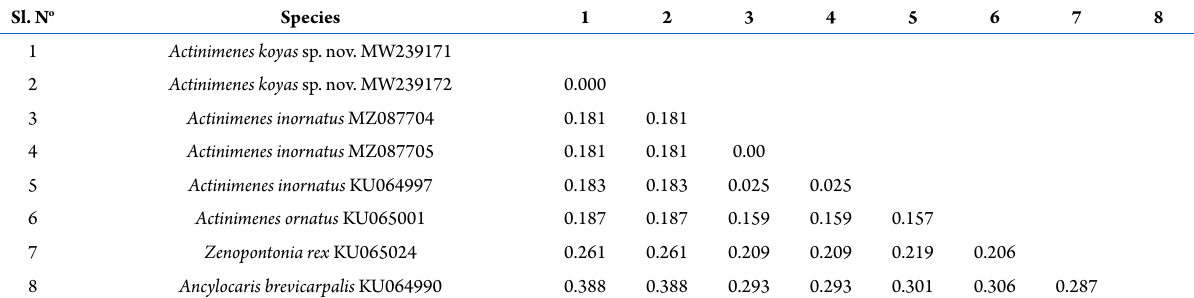
Table 3. Pairwise genetic distances calculated using Kimura 2-parameter model with COI sequences of genus Actinimenes, Ancylocaris and